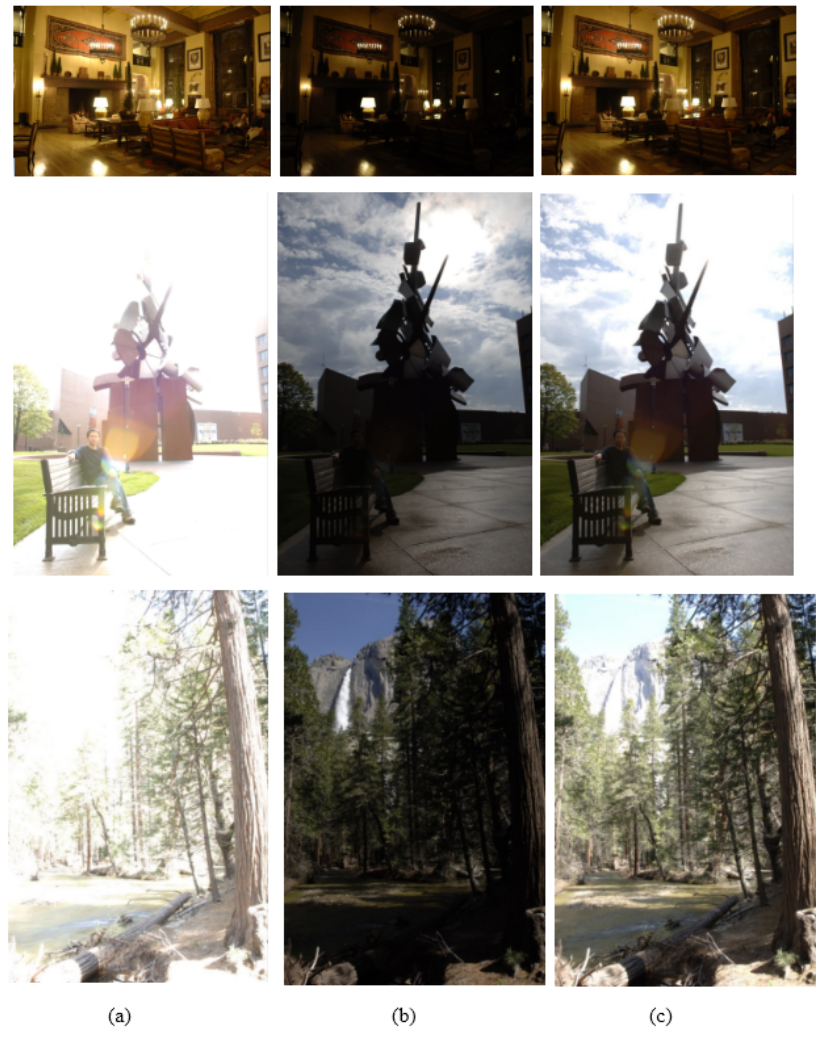
Figure 4: (a) Input image with high luminance (b) Input image with low luminance (c) output